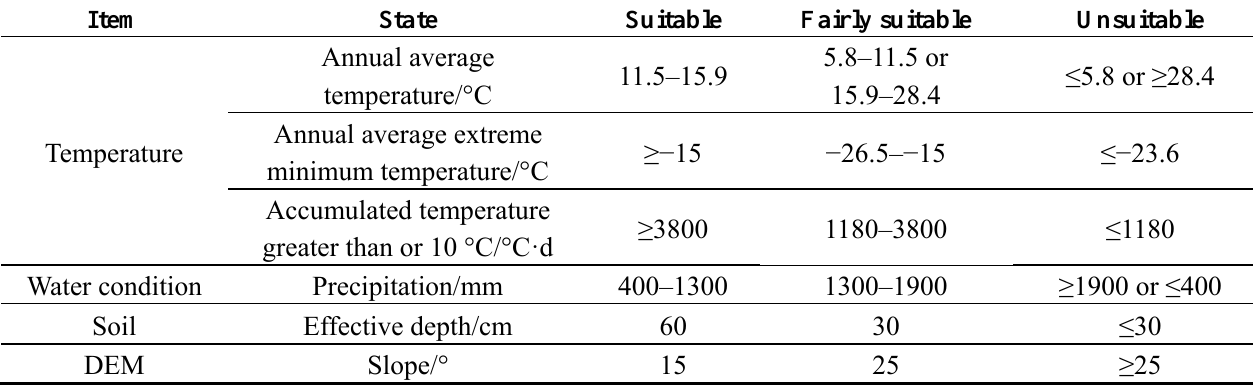
Table 2. Temperature, moisture and soil under three categories of land suitability for Pistacia chinensis